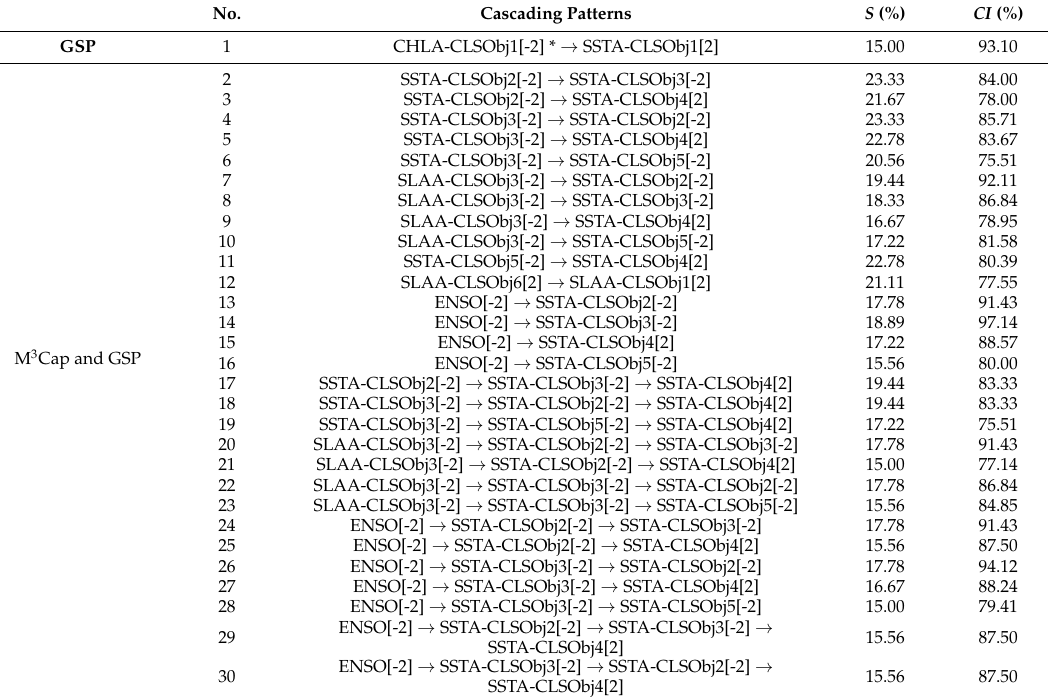
*CLSObj with a number after the marine parameters indicates the research area, the number within the square bracket indicates the variation degree (e.g., CHLA-CLSObj1[-2] means that in region CLSObj1, CHLA shows an abnormal decrease compared with the monthly averaged).